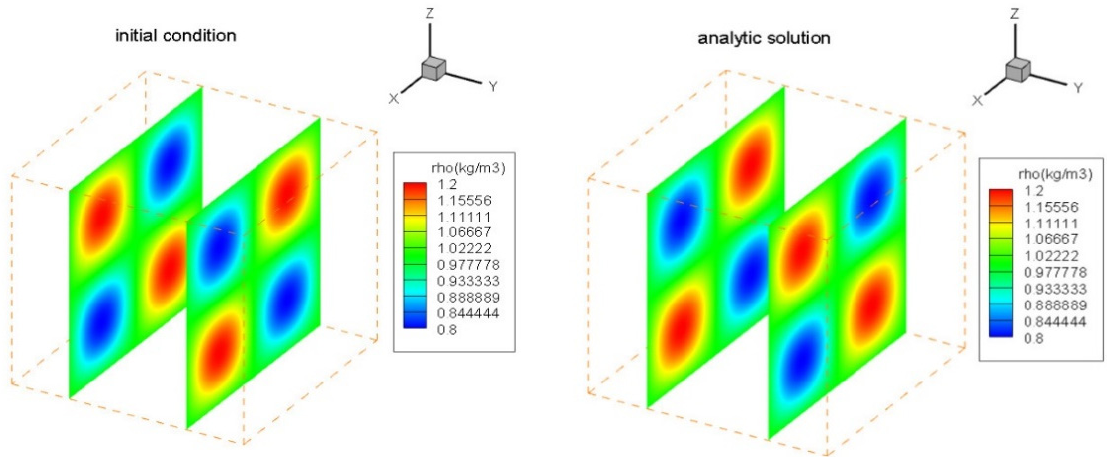
Figure 1. IC and the analytic solution of the density at 1.0 s. Table 2. Cases to be simulated in the order of accuracy verification of the 3D solver ( r (cid:2934) = r (cid:2930) = 2 ). No. Cells